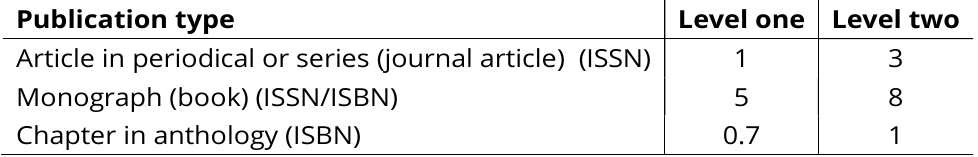
Table 1. Publication points given to different types of approved scientific or scholarly publication in the Norwegian model (CRIStin